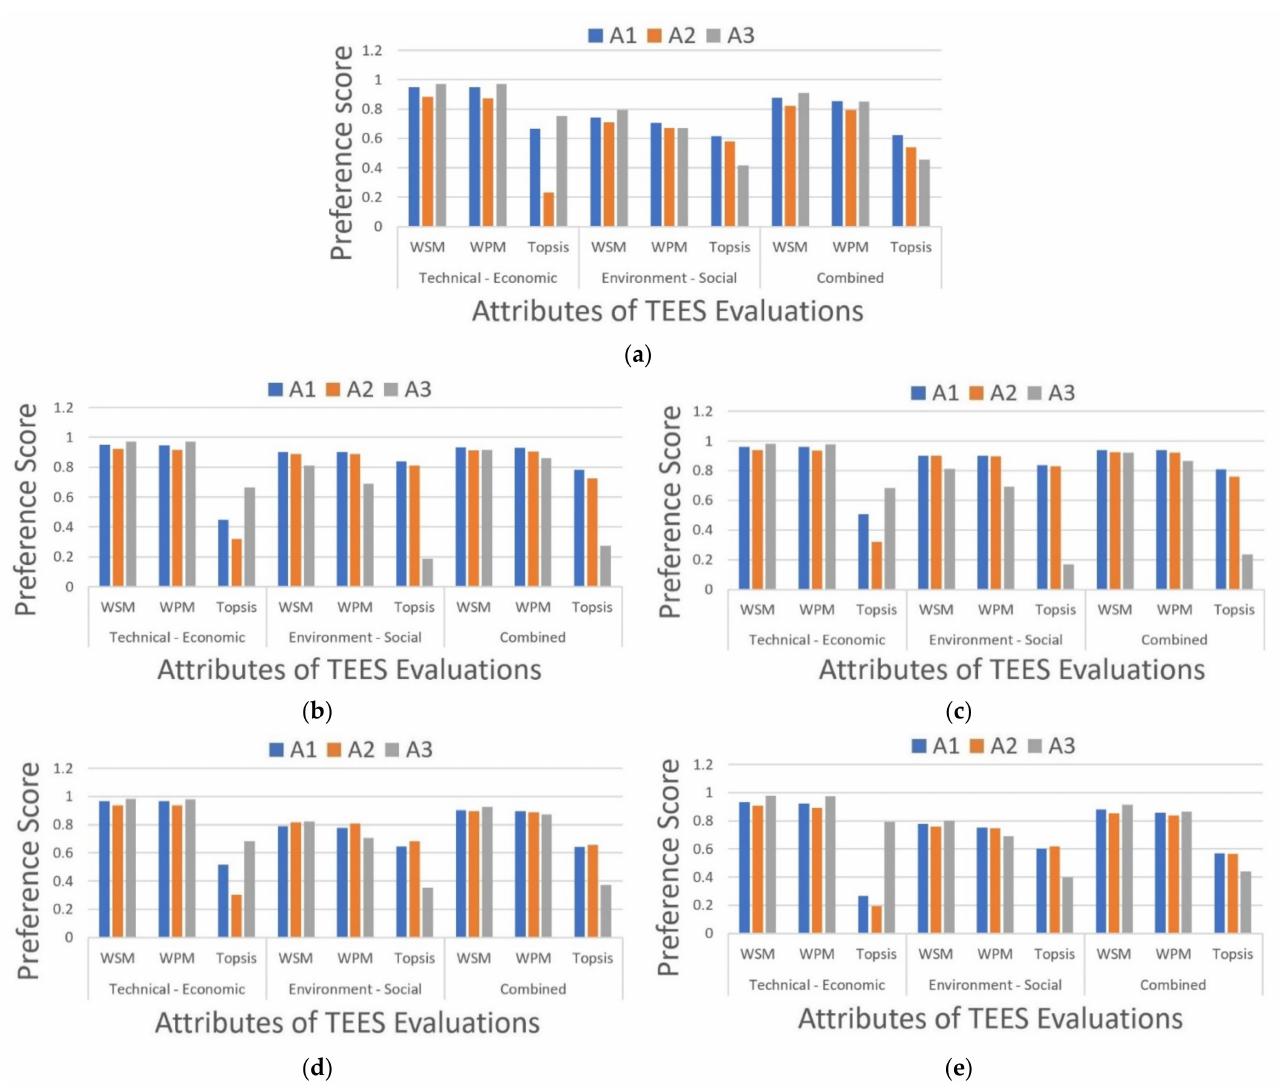
Figure 21. MCDM evaluations for Case 4 considering DG + DSTATCOM: ( a ) C4/S1 (NL); ( b ) C4/S2 (LG1); ( c ) C4/S3 (OLG1); ( d ) C4/S4 (LG2); ( e ) C4/S5 (OLG2).